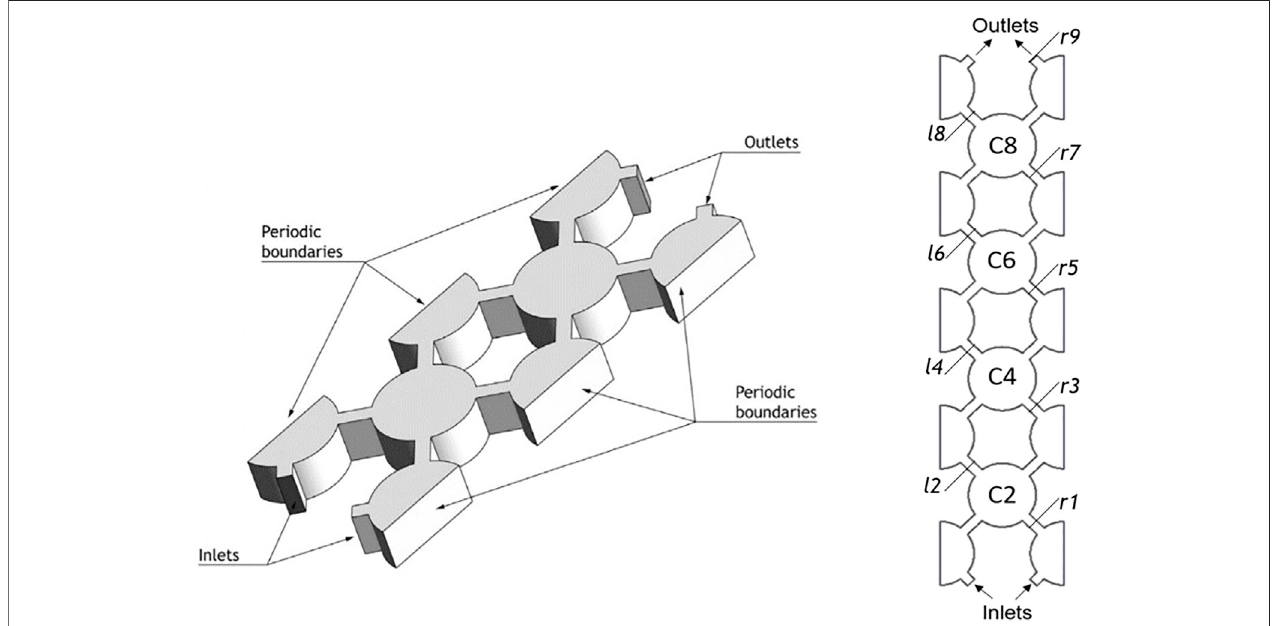
FIGURE 3 | Schematic representation of: NUB (Fonte et al., 2013) (left) and ExtendedNUB (with chambers 2, 4, 6, 8) (right) .